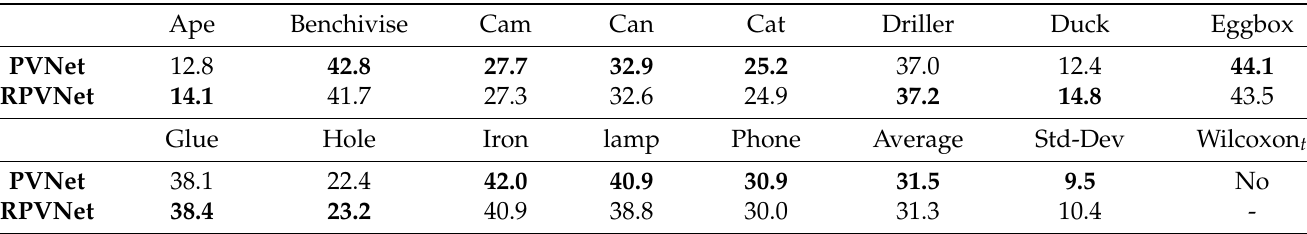
Table 3. Test results of accuracy on Truncation